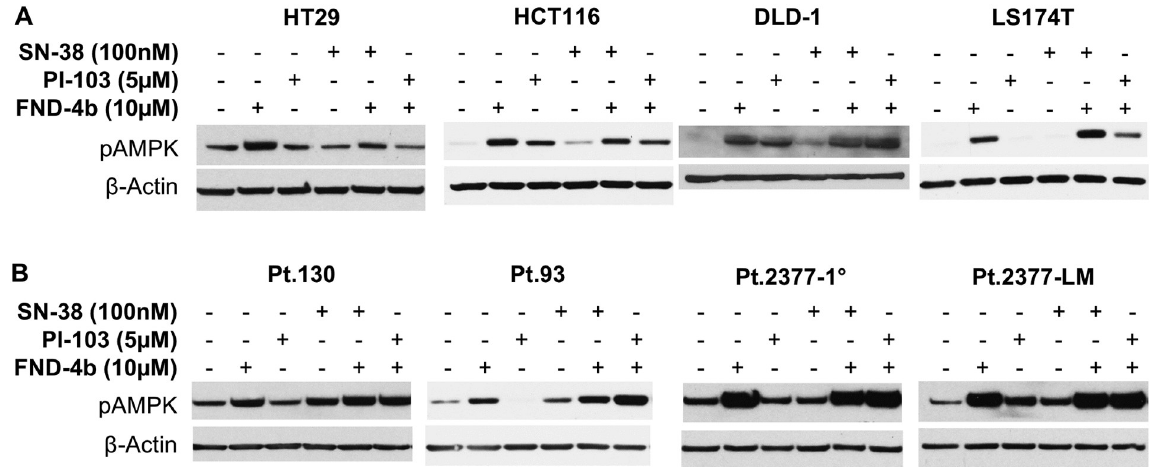
Fig 2. AMPK activation in commercial & PDX-derived CRC cell lines treatment combinations. Western blot analysis indicated that AMPK activation was increased in commercially-available CRC cell lines (A) and PDX-derived cell lines (B) after monotreatment or combination treatment with FND-4b (10 μ M), PI-103 (5 μ M), or SN-38 (100nM) for 24 h compared to the untreated control. β -actin was used as the loading control. The images are representative of three independent experiments.